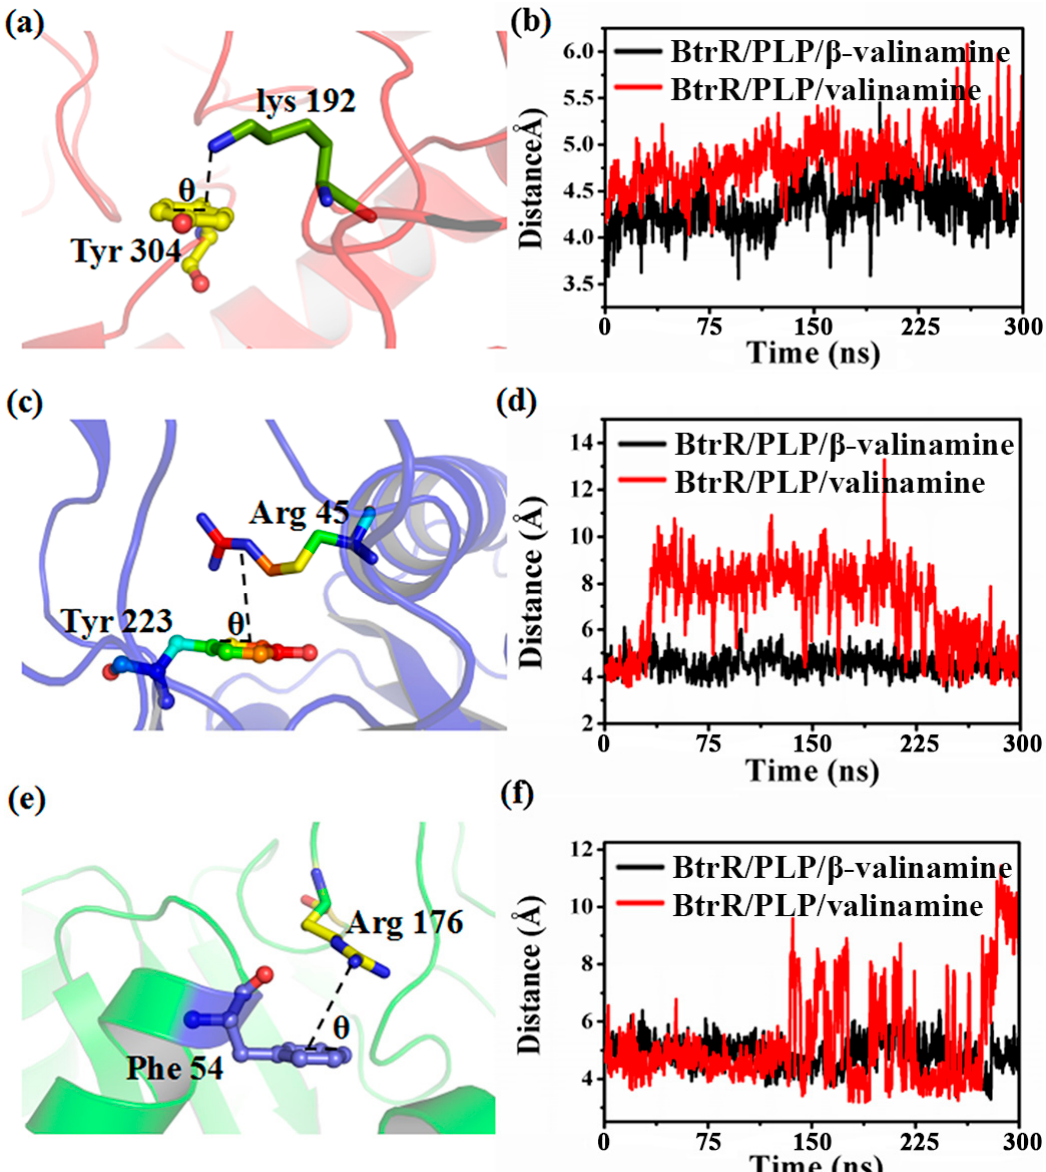
Figure 6. Distance between the ( a ) aromatic ring and cation of Tyr 304 and Lys192, ( c ) aromatic ring and cation of Tyr 223 and Arg45, ( e ) aromatic ring and cation of Phe45 and Arg176. Distance between ( b ) Tyr 304 and Lys192, ( d ) Tyr 223 and Arg45, ( f ) Phe45 and Arg176 was calculated from the cation to the centroid of the aromatic in chain A during the 300-ns MD of BtrR/valienamine and β -BtrR/valienamine, respectively.